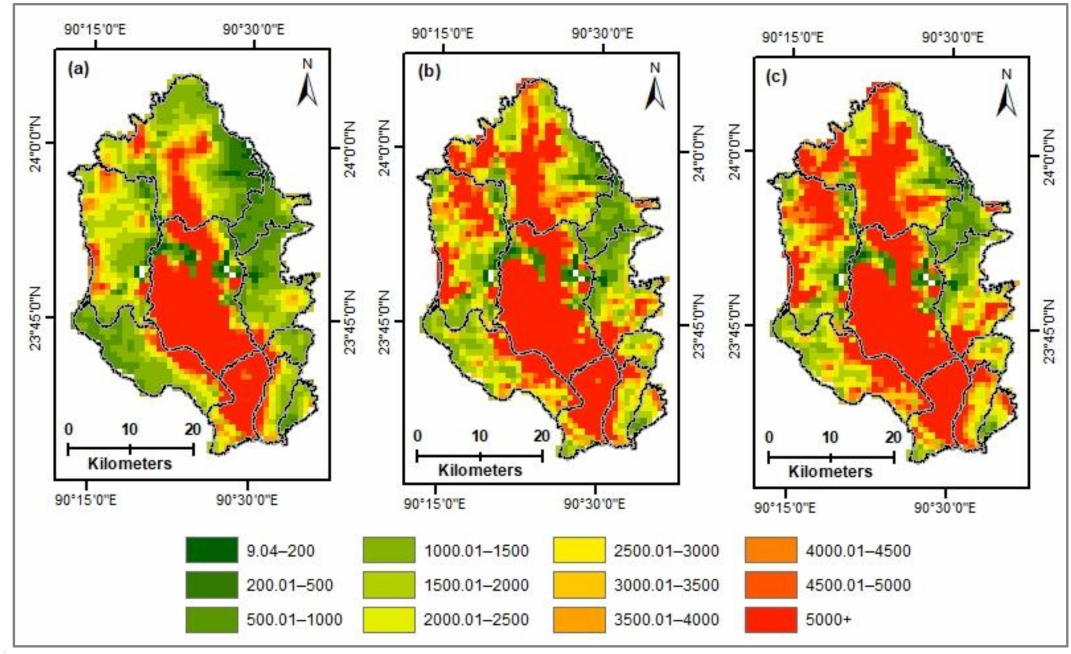
Figure 17. ( a ) Spatial distribution of 2001 population; ( b ) spatial distribution of 2016 population; ( c ) spatial distribution of 2020 population (derived from WorldPop and CIESIN [45]).